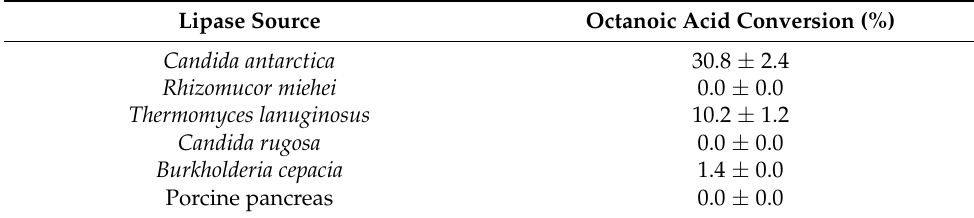
Table 1. Esterification of thymol and octanoic acid using lipases in soluble form in a solvent-free system. Reaction conditions: 2 mmol of octanoic acid, 2 mmol of thymol, 200 µ L of enzymatic aqueous solution, 50 ◦ C and 24 h of